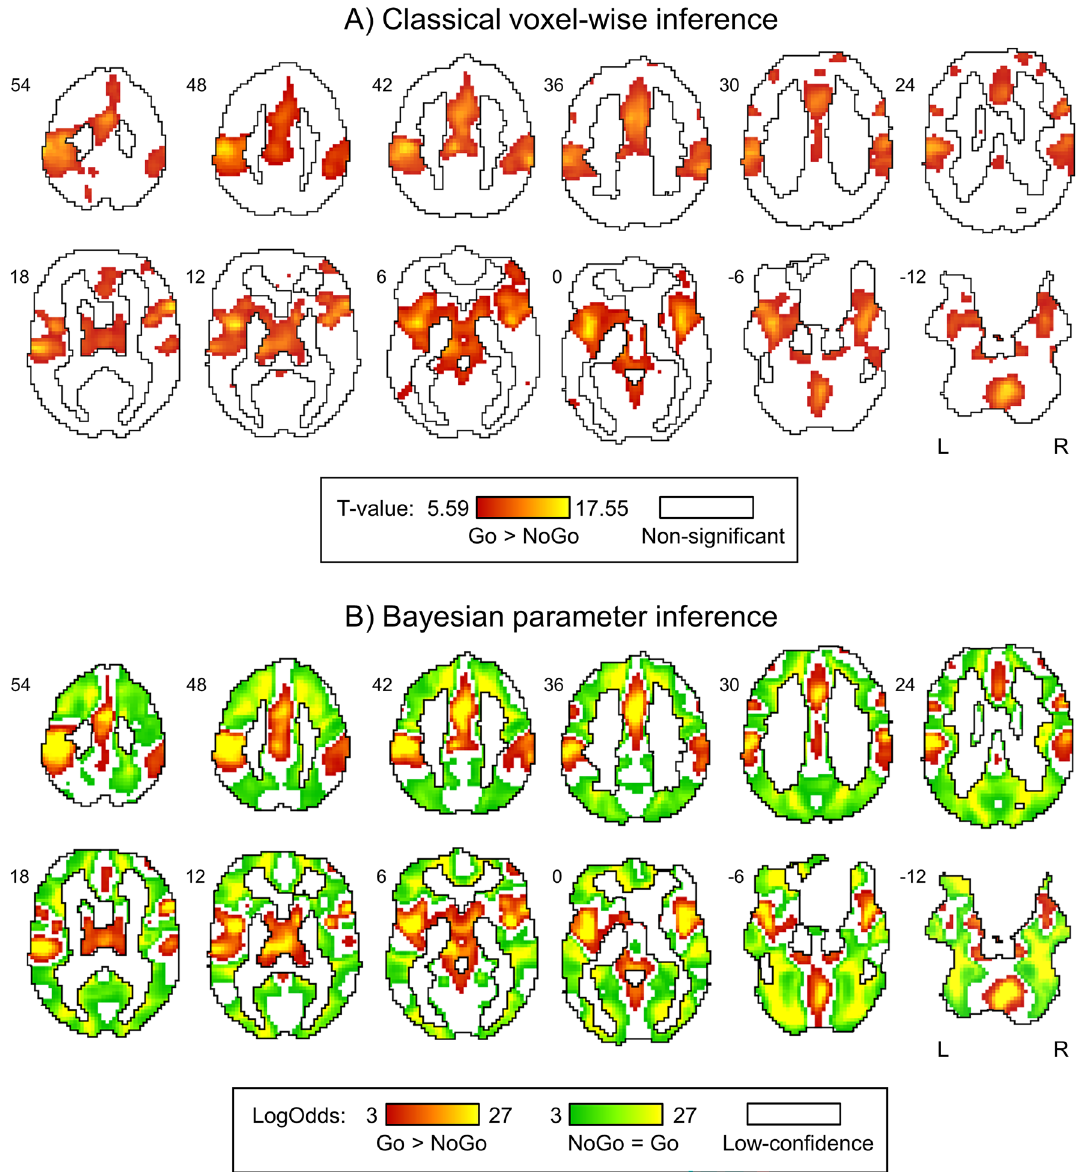
Figure 4. Results of classical voxel-wise and Bayesian parameter inference. ( A ) Classical NHST inference with an FWE-corrected voxel-wise threshold of 0.05. ( B ) BPI with the effect size threshold γ = 1 prior SD θ = 0.1%, LogOdds > 3 ( PP > 0.95). The “NoGo > Go” effect was not detected by any of the methods. Red colour depicts the “Go > NoGo” effect. Green colour depicts the “NoGo = Go” effect (practical equivalence of neuronal activity in Go and NoGo trials). White colour depicts ( A ) non-significant voxels and ( B ) “low-confidence” voxels. Figure was created using Mango 4.1 software (https:// ric. uthsc sa. edu/